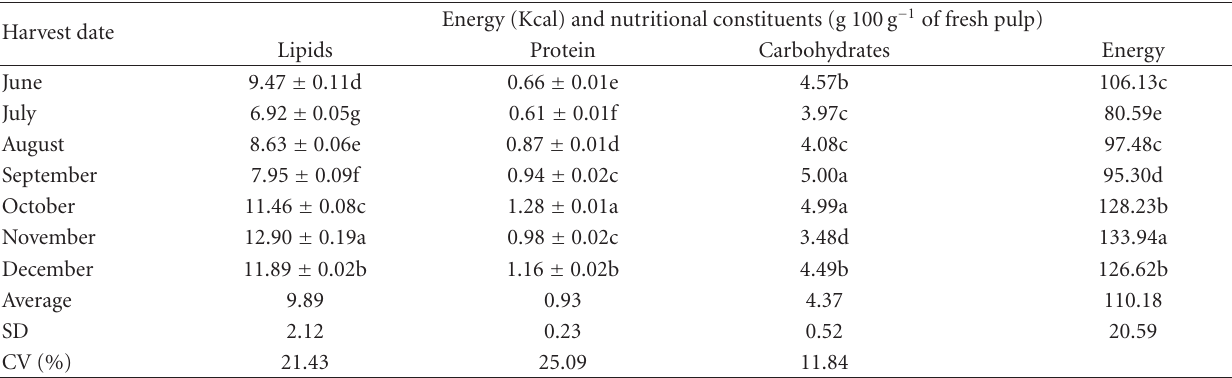
Table 4: Nutritional value of the patau´a ( Oenocarpus bataua Mart.) fruits from the Adolpho Ducke Forest Reserve localized in Manaus, Amazonas, Brazil, and harvested at di ff erent times during the